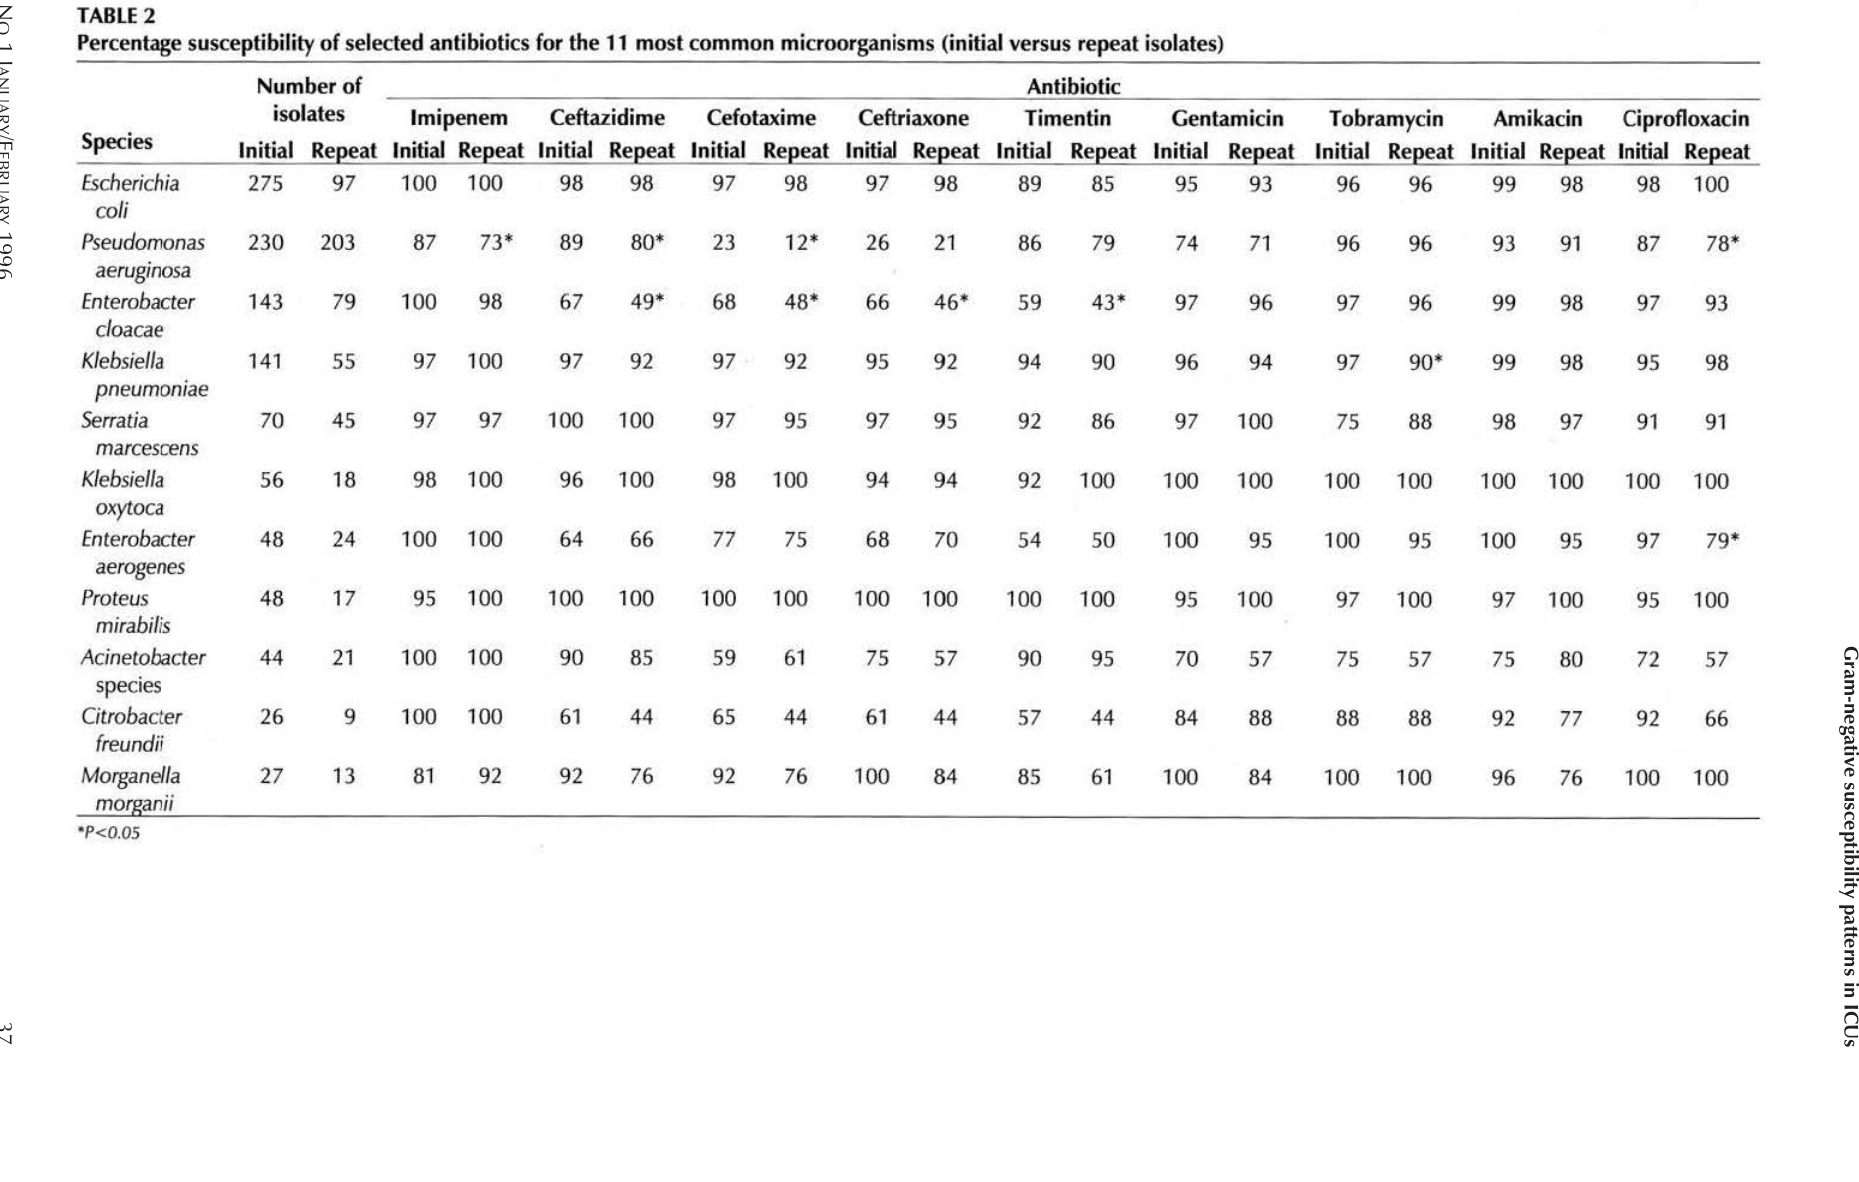
Percentage susceptibility of selected antibiotics for the 11 most common microorganisms (initial versus repeat isolates) Number of Antibiotic